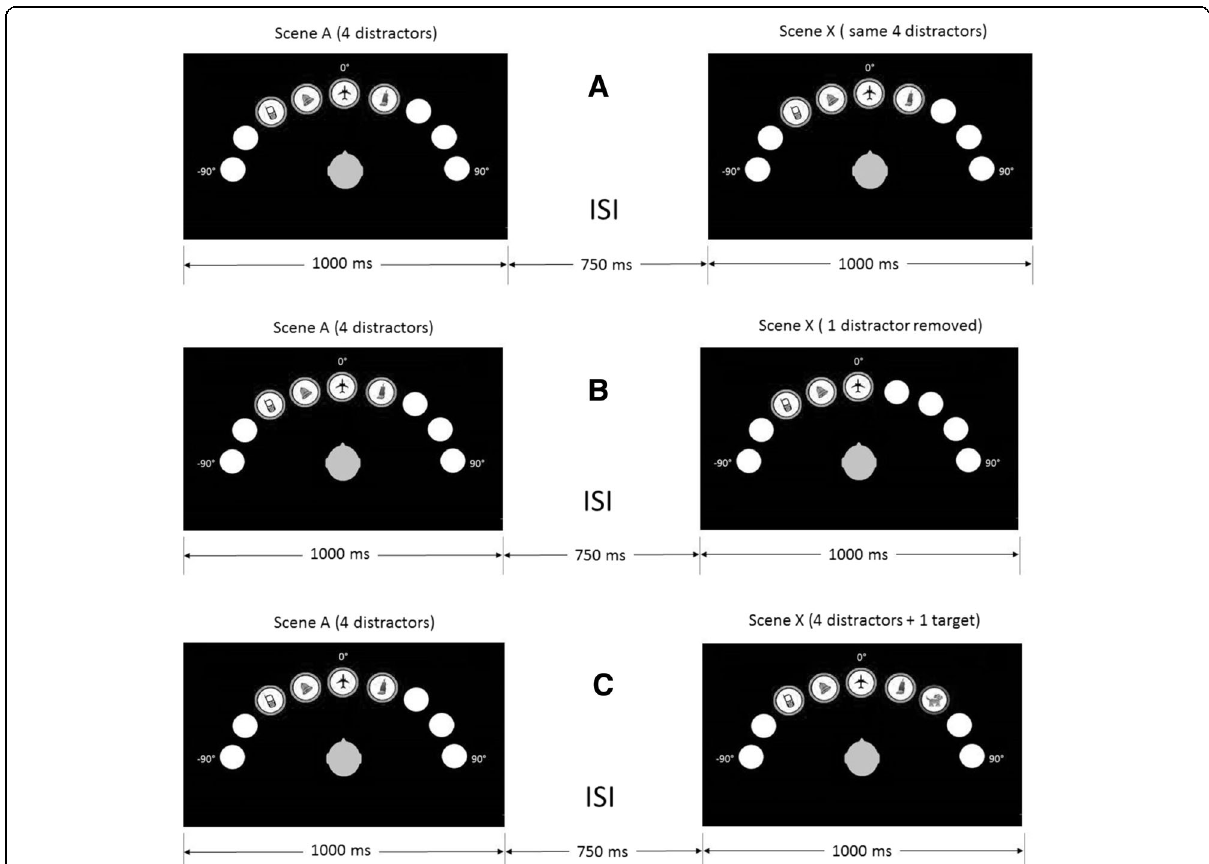
Fig. 2 Trial structure was the same for both the spatially separated (multi) and spatially co-located conditions (mono); listeners would hear scene A (1000 ms) and after a brief inter-stimulus interval scene X. The top ( a ) panel depicts a No-change trial, the middle ( b ) panel a Remove trial, and the bottom ( c ) panel an Add